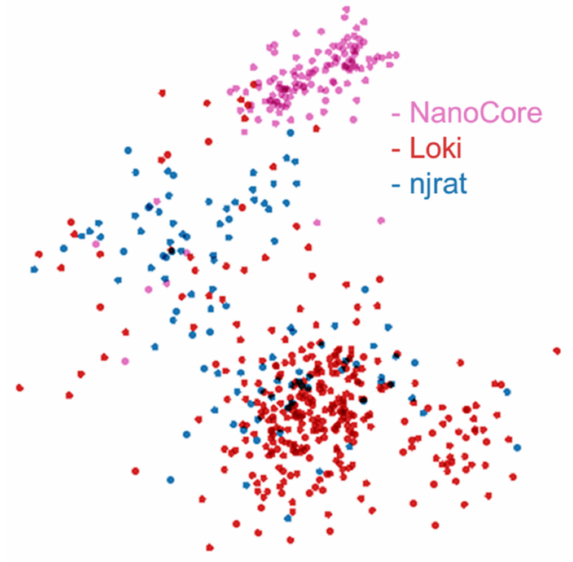
Figure 13. Visualization of an unseen dataset using